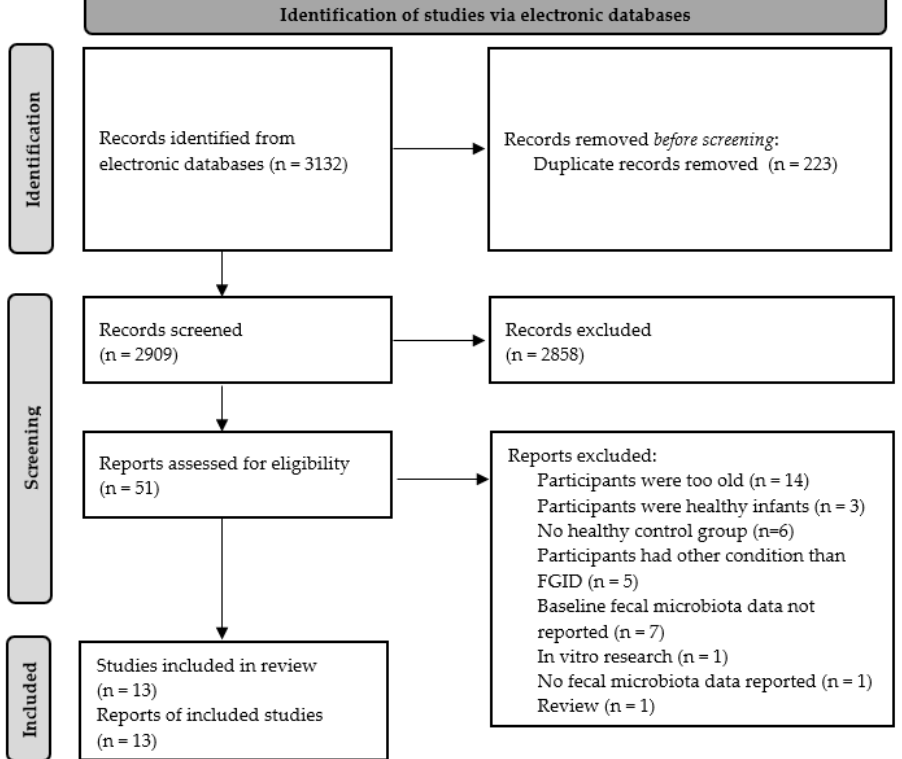
Figure 1. Systematic review flow diagram.